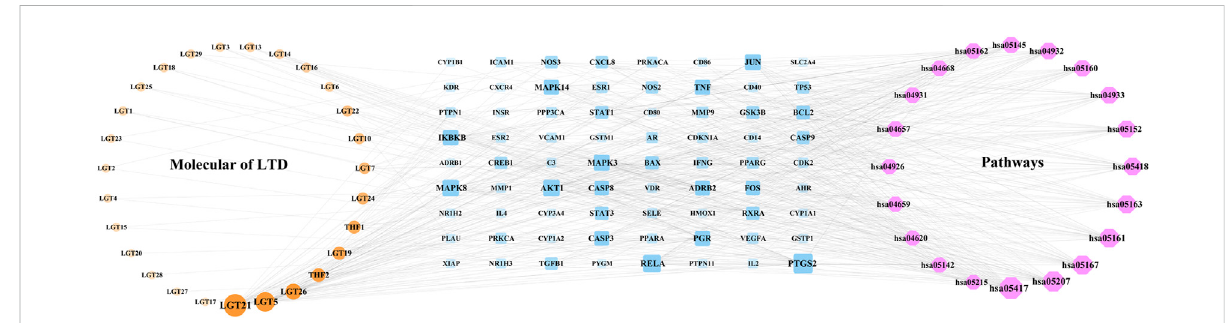
FIGURE 6 Network of herb-component-target-pathway. The yellow nodes represent the herb component, the blue nodes represent the LTD-DKD- KEGGpathway common target,and thered nodesrepresentstheKEGGpathway. Thenodeswith alarger areaand darkercolorhavealarger degree